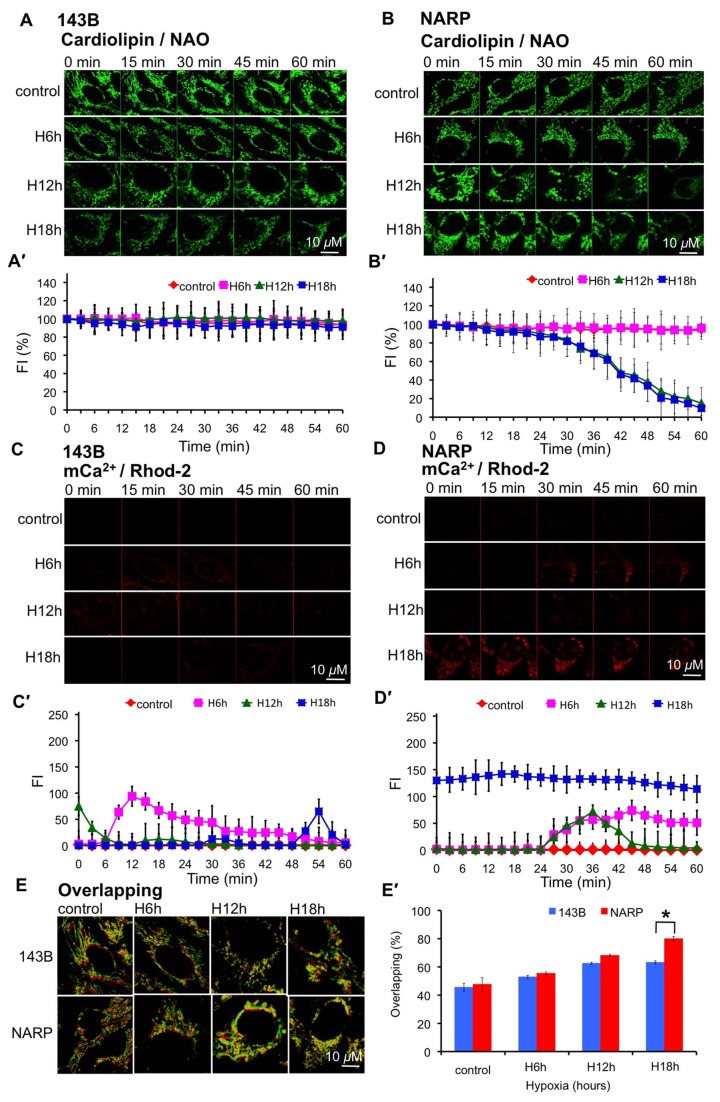
Effects of H/RO (with different hypoxia durations) on mitochondrial functions in NARP cybrids and 143B cells.(A) After treating 143B cells with H/RO (H: 6, 12, and 18 h; RO: 2 h), no obvious cardiolipin depletion was noted during recording. Mitochondria remained thread-like. (B) Cardiolipin depletion was noted gradually in NARP cybrids receiving H/RO with durations of hypoxia for 12 and 18 h. Mitochondria became swollen and round. (C) In 143B cells, only transient mCa2+ accumulation was noted (D) Marked and persistent mCa2+ accumulation was noted in NARP cybrids exposed to H/RO with duration of hypoxia for 18 h. (E) Red/green overlay of two consecutive confocal images (Δt = 2min) of 80 nM nonyl acridine orange (NAO) fluorescence in NARP cybrids and 143B cells upon H/RO with different hypoxia durations. The percentage of nonmoving mitochondria (overlapping mitochondrial area, in yellow color) to total mitochondrial area increased from 45 ± 3.2% to 63 ± 1.4% in 143B cells and 48 ± 5.1% to 77 ± 2.3% in NARP cybrids after the exposure of cells to H/RO with duration of hypoxia for 18 h. P-value representing statistically significant differences between NARP cybrids and 143B cells is indicated (*). (A′-E′) Quantitative analyses of A-E. n=6.